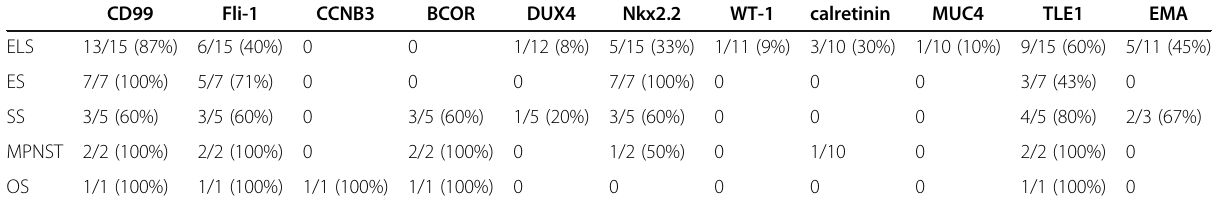
Table 3 IHC characterisations in the 15 cases of Ewing-like sarcoma and 15 cases of negative controls